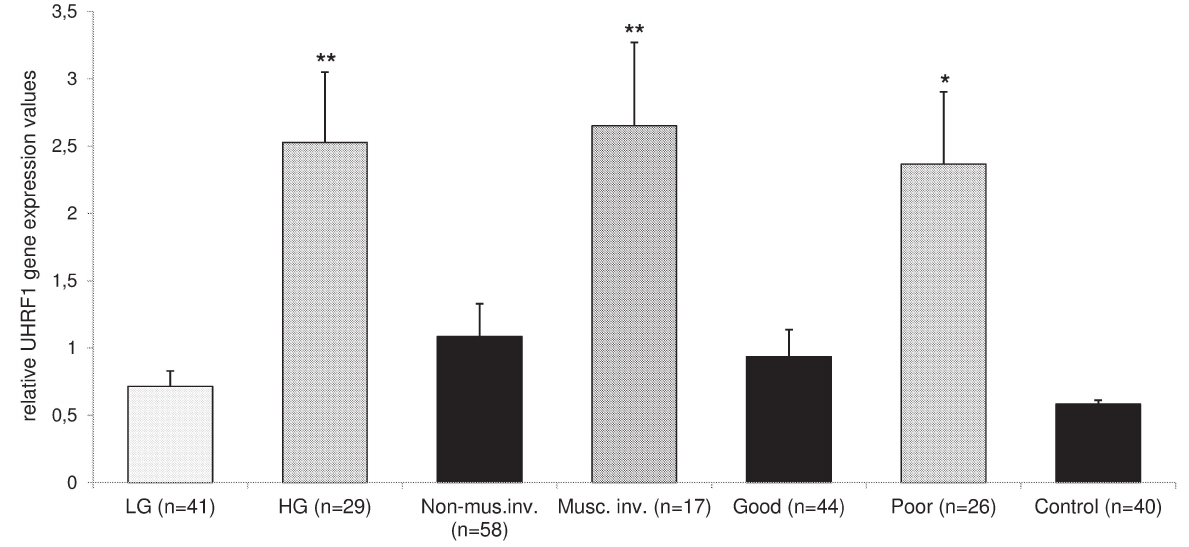
Figure 1 - UHRF1 expression correlation with the T-classification grades, stages and the clinical outcome during 2-year follow-up of urinary bladder TCC